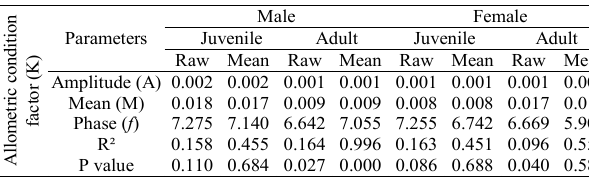
Table 2. Parameters of the sinusoidal equation for the variation of raw and bimonthly means in the condition factor (K) in Auchenipterichthys longimanus collected from July 2008 to July 2009 in the Caxiuanã National Forest. iti ond